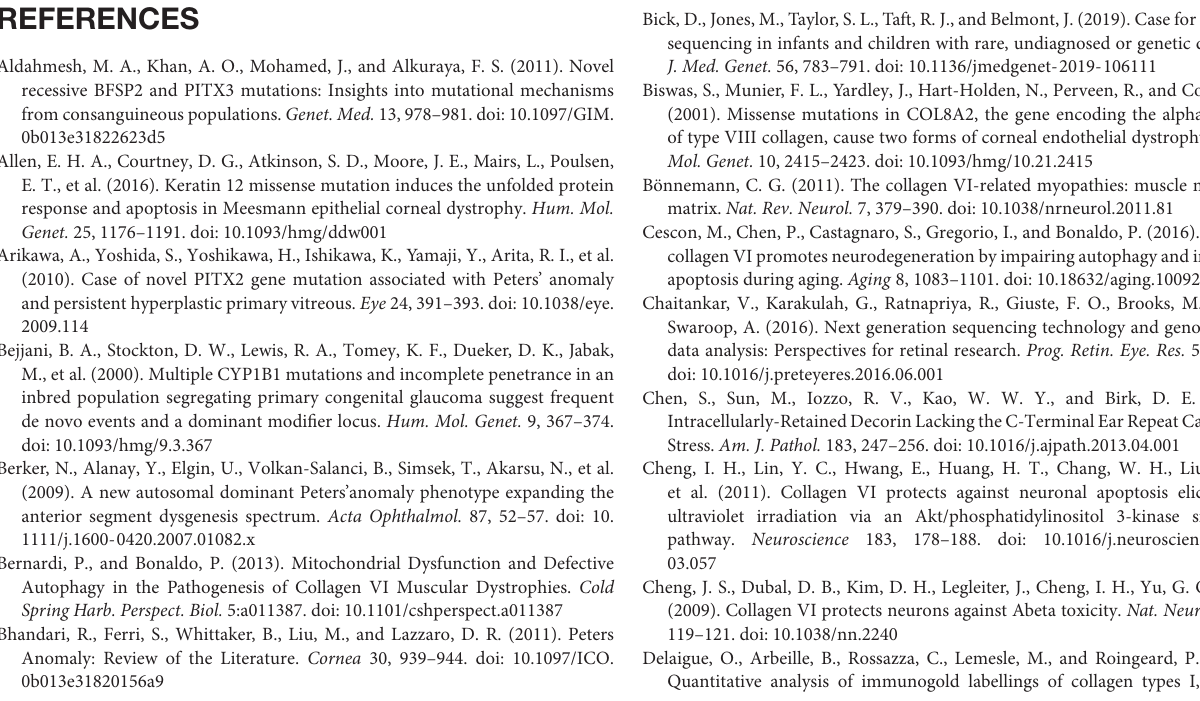
Supplementary Figure 1 | Screening of the major COL6A3 isoform that expressed in human cornea. (A) The electrophoresis results of PCR products from different COL6A3 isoforms in six independent human cornea samples. The product length of NM_004369 was 180 bp, while the one of NM_057164/NM_057165 was 197 bp. (B) Relatively higher expression of COL6A3 isoform NM_057164/NM_057165 in human cornea detected by RT-qPCR ( N = 4, P = 0.017). (C) The structural difference between the two COL6A3 isoform-coding sequences, and locations of the COL6A3 mutations